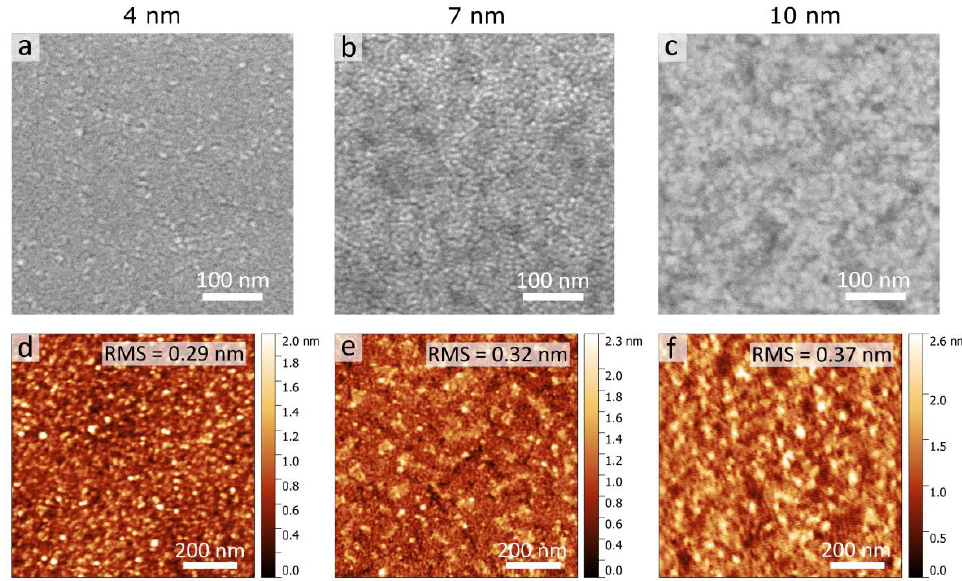
Figure 2. SEM surface images ( a – c ) and AFM topography scans ( d – f ) of Au films of varying thickness on few-layer MoS 2 flakes. Values of RMS surface roughnesses of the Au films are indicated within AFM images. The AFM scan area is 1 × 1 μm 2 .